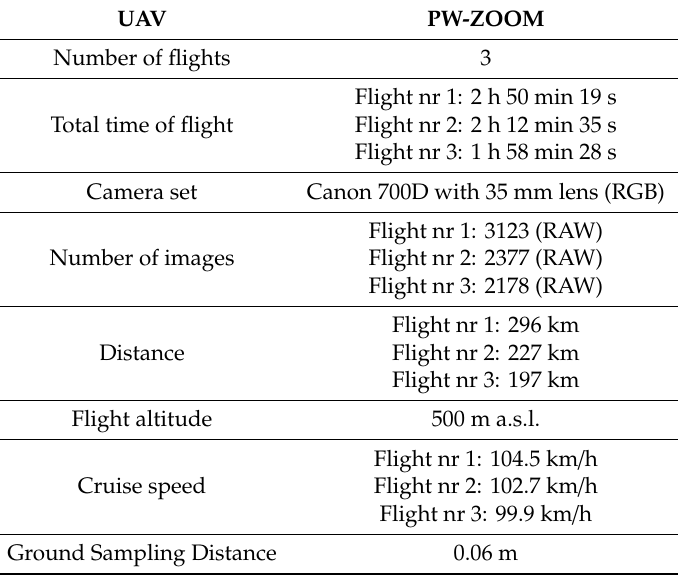
Figure 3 . Unmanned aerial vehicle flight routes during the Beyond Visual Line of Sight operation over the west coast of Admiralty Bay. Table 1. The parameters of the aerial survey to the Antarctic Specially Protected Area No. 128 performed on 15–17 Nov. 2016.